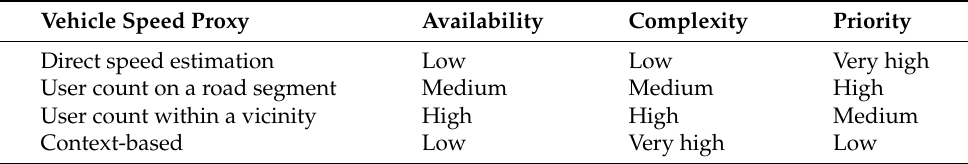
Table 6. Different types of proxies for geo-tagged Twitter data used in traffic modelling. Availability and priority should be high while complexity should be low for good results of traffic forecast